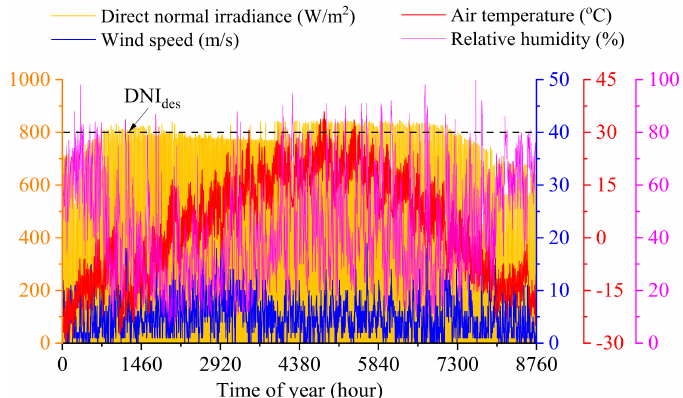
Figure 4. Annual distributions of solar and climate data in the selected location.